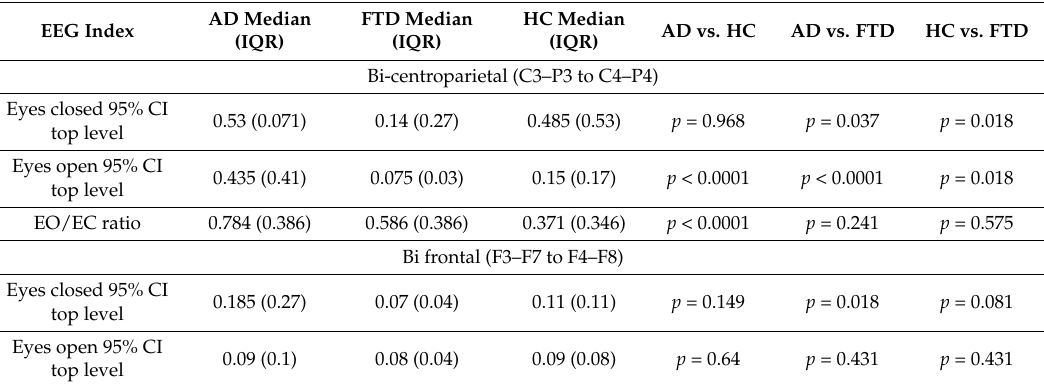
Table 2. QEEG results-ERR-causality test.